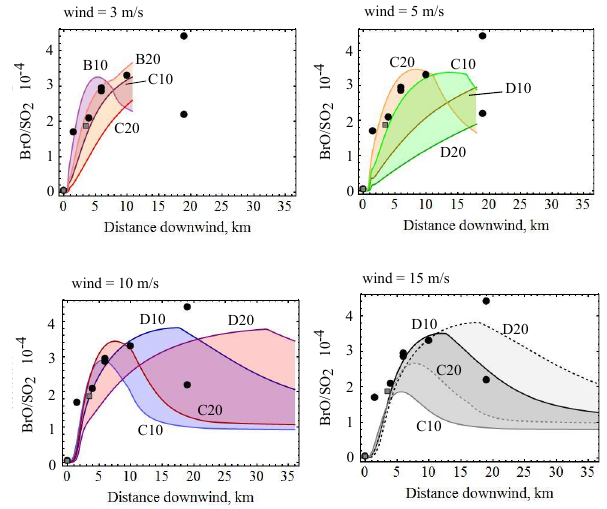
Figure 6. Simulated BrO/SO 2 over 1h for the medium bromine emission, predicted for two emission flux scenarios (10 or 20kgs − 1 ), and for a range of wind speeds (3, 5, 10, 15ms − 1 ), and Pasquill–Gifford dispersion schemes (B, C, D). See text for details of the combinations. Model runs are compared to observations from Bobrowski et al. (2007) and Oppenheimer et al. (2006), shown as black circles and grey squares,